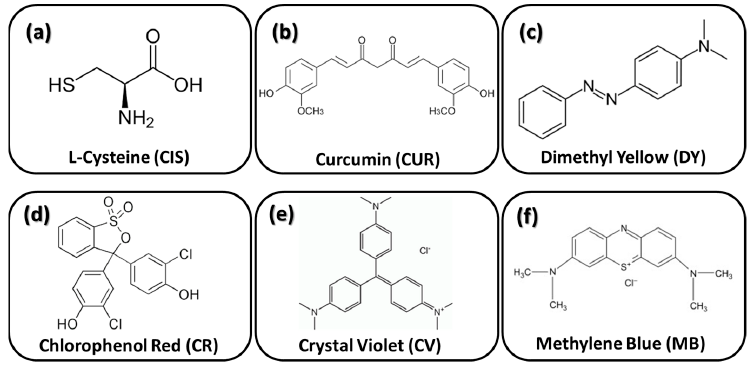
Figure 8. Corrosion inhibitors added into the sol-gel coatings: ( a ) L-cysteine; ( b ) curcumin; ( c ) dimethyl yellow; ( d ) chlorophenol red; ( e ) crystal violet; and ( f ) methylene blue.